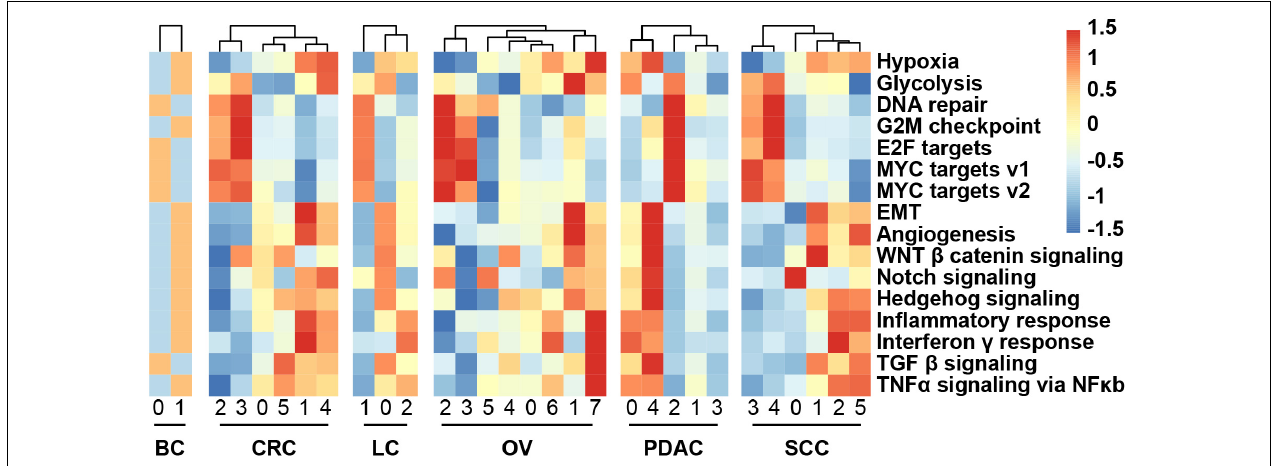
FIGURE 3 | Heatmap showing different hallmark gene sets enriched in the cancer cell subclusters by GSVA, colored by Z -score-transformed mean GSVA